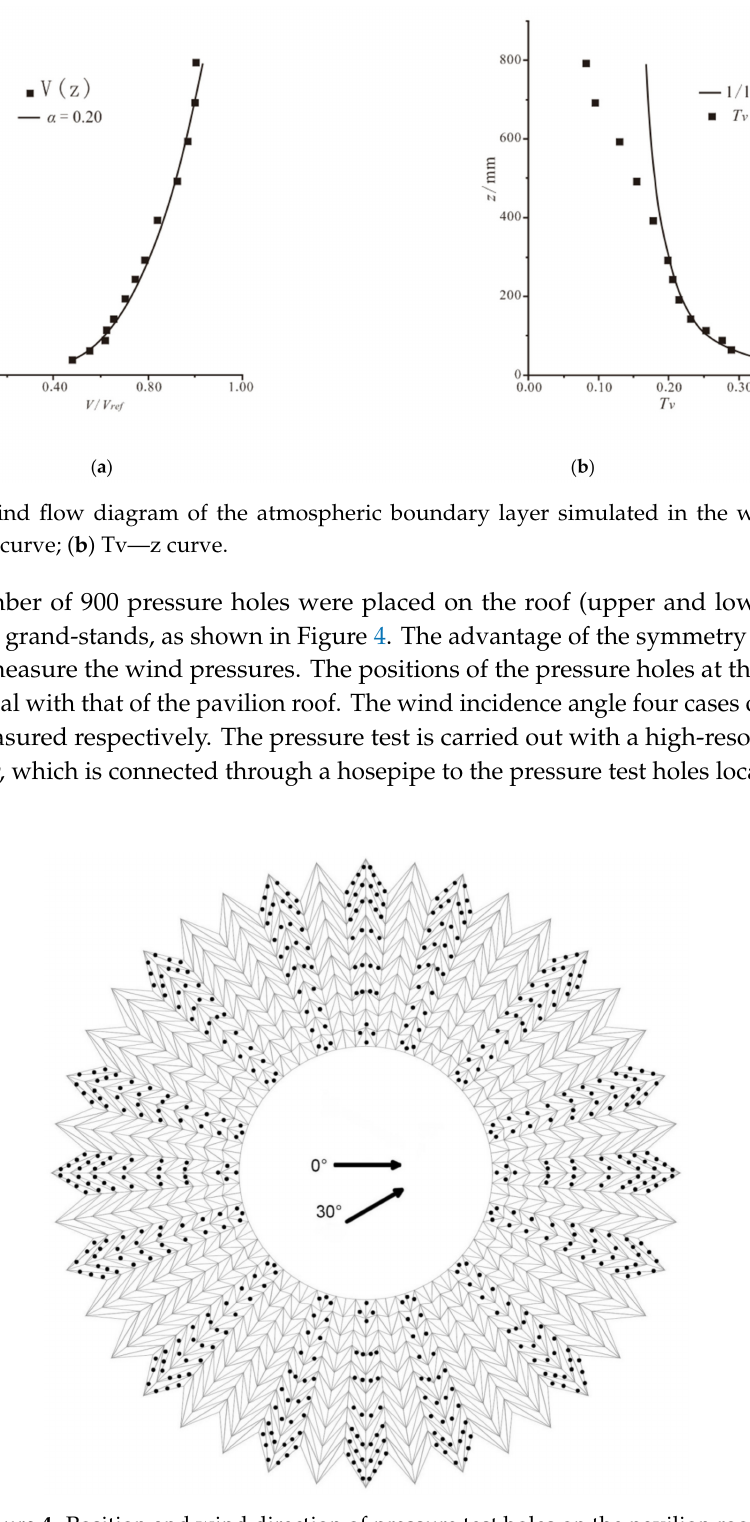
Figure 4. Position and wind direction of pressure test holes on the pavilion